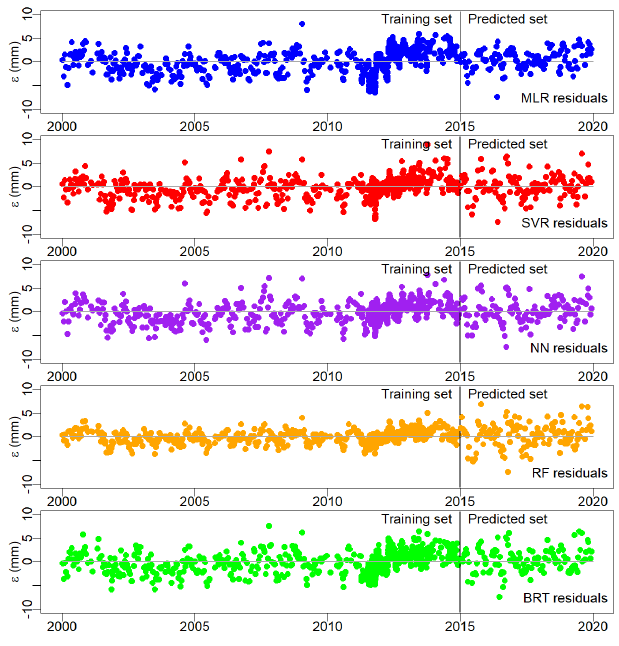
Figure 20. Residuals along the training and the predicted